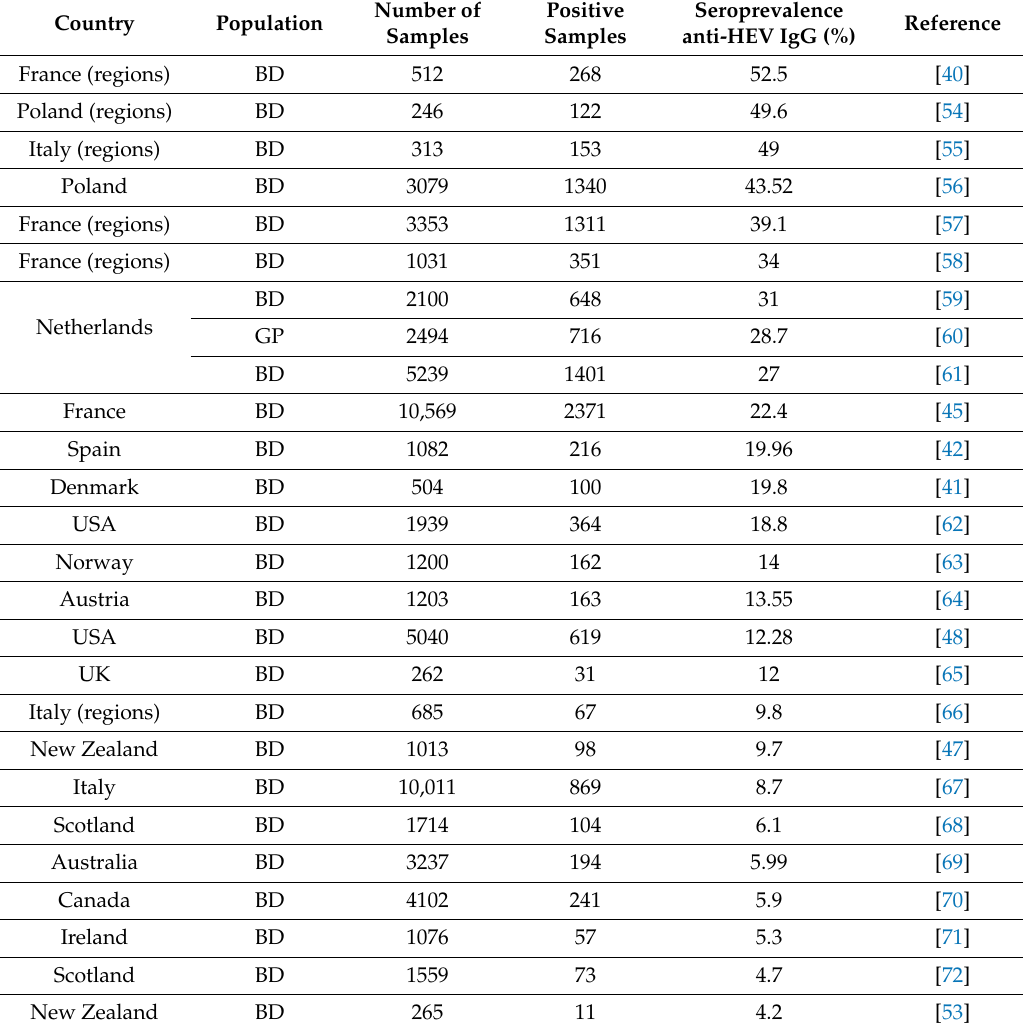
Table 2. Comparison of seroprevalence rates observed with the Wantai HEV-IgG ELISA assay in blood donors (BD) and the general population (GP) (data used for meta-analyses). “Country (regions)” means the seroprevalence is at regional